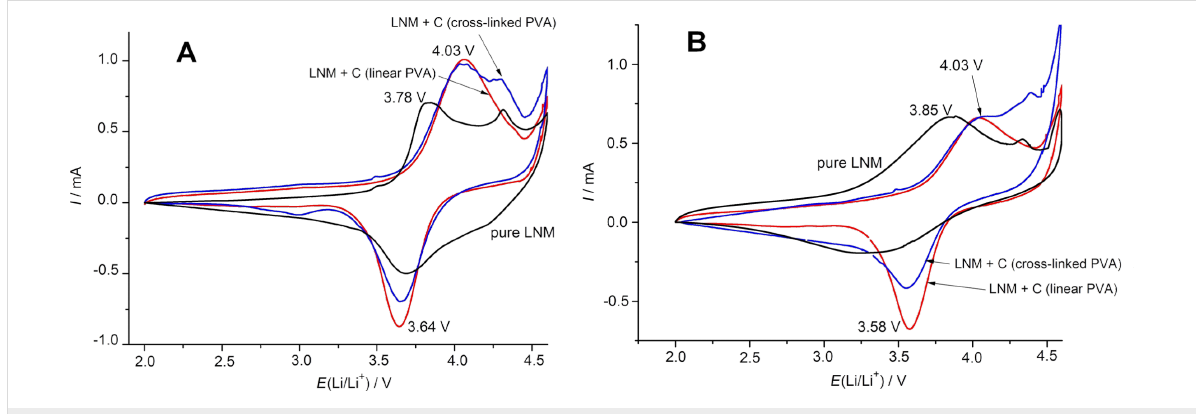
Figure 4: CVA curves of pure Li 1.4 Ni 0.5 Mn 0.5 O 2+ x and LNM/C nanocomposites at the 1st cycle (A) and after galvanostatic cycling (B) at discharge currents of 20–100 mA·g − 1 (the 15th cycle). Potential scan rate is 50 µV·s − 1 .